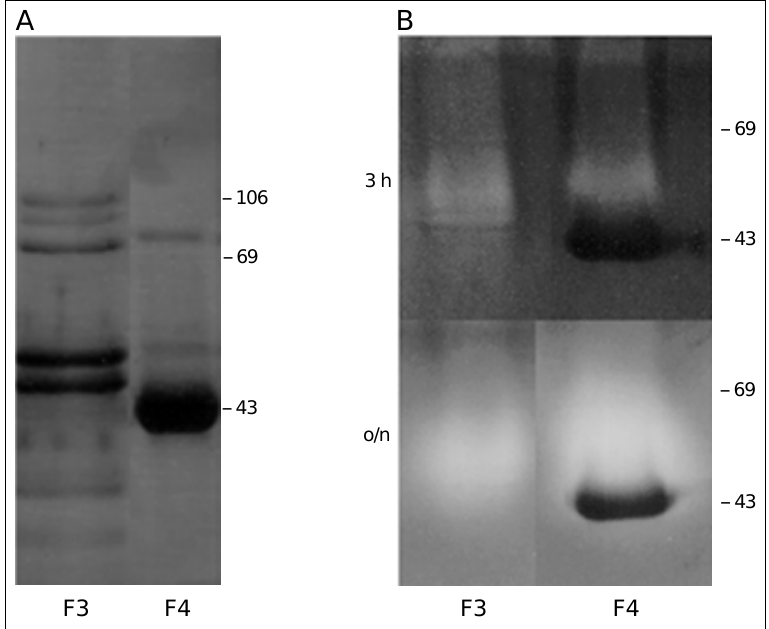
Figure 2 - Silver-stained SDS-PAGE (A) and zymogram (B) profiles of F3 and F4 fractions of P. brasiliensis exocellular components. For the zymograms, the polyacrylamide gels were impregnated with 0.1% gelatin. After the electrophoretic run, the gels were washed with buffered MeOH, as indicated in the text, and incubated at 37 o C in 50 mM Tris-HCl, pH 8.5, for 3 h or overnight (o/n), as indicated. Proteolytic bands were visualized by staining with Coomassie brilliant blue. The amounts loaded onto the gels were: 0.5 µg of F3 and 1 µg of F4 for silver staining and 5 µg of F4, 1.25 µg (3 h) or 0.25 µg (o/n) of F3 for zymograms. Molecular weight markers (kDa) are indicated on the